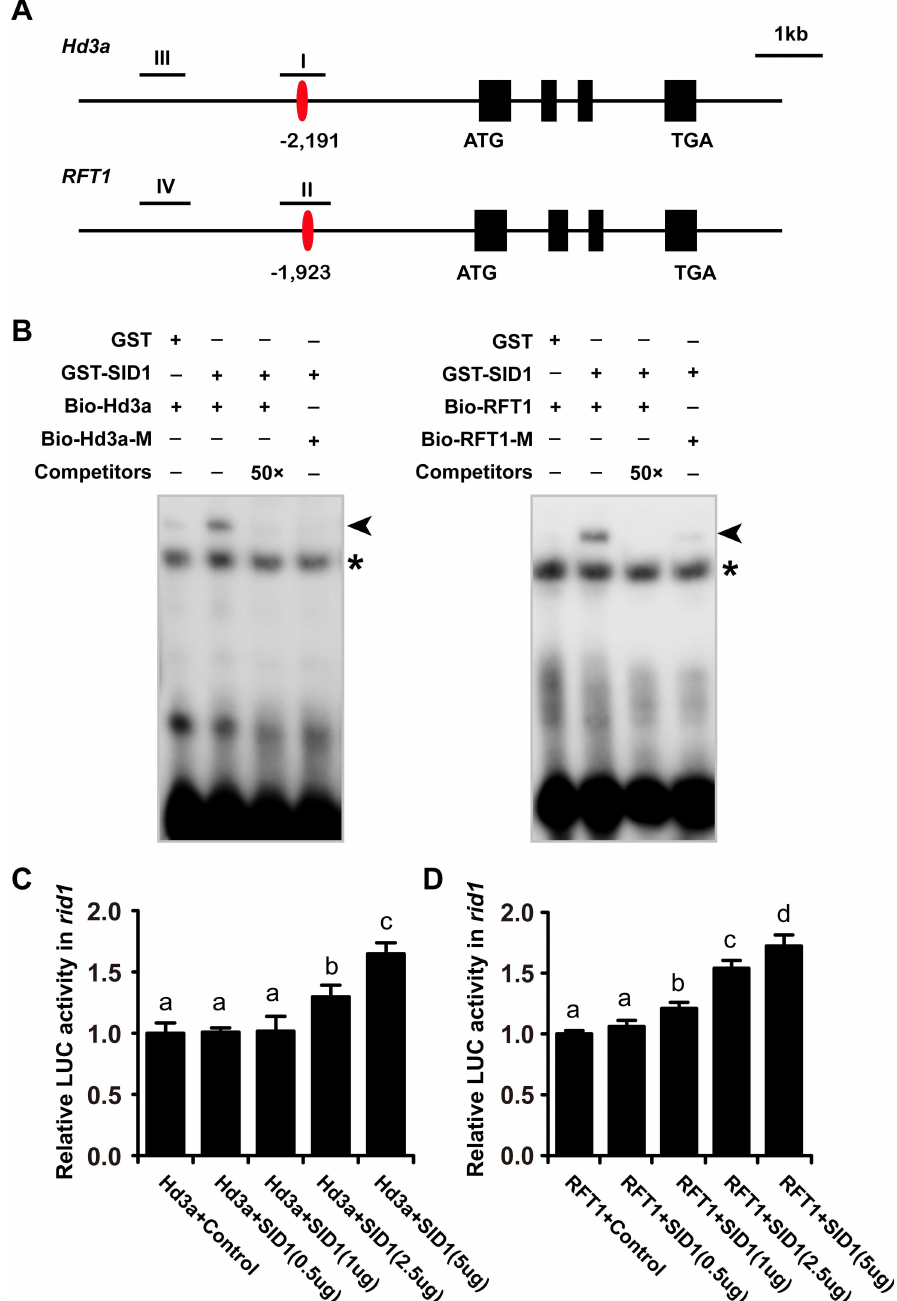
Fig 7. SID1 is able to activate Hd3a and RFT1 expression. (A) Schematicrepresentation of putative loci of SID1 bindingsites in the promoter of Hd3a and RFT1 . The red bars represent the core sequencecontaining TTTGTC. The numbers indicate the position relative to the start codon. The precipitated chromatinfragments wereanalyzedby qPCR using four primer sets amplifying Hd3a and RFT1 regions(I, II, III, and IV) as indicated, respectively. (B) EMSA showedthat SID1 couldbind to the core sequencecontainingTTTGTC in the Hd3a and RFT1 promoter in vitro .The Hd3a and RFT1 promoterfragments containing the core sequencewere incubated with GST and GST-SID1 protein in vitro . Unlabeled Hd3a and RFT1 promoterfragments were usedto compete for SID1 binding.The fragment with mutatedcore cis-element servedas the negative control. Trianglesand asterisksindicateshifted bandsand nonspecific binding,respectively. (C) and (D) Ratioof firefly luciferase (LUC) to Renillaluciferase (REN) activity in rid1 protoplaststransformed with varies dosageof SID1. Data representmeans ± SDs ( n = 4). Statisticalanalysesare basedon a two-way analysisof variance.